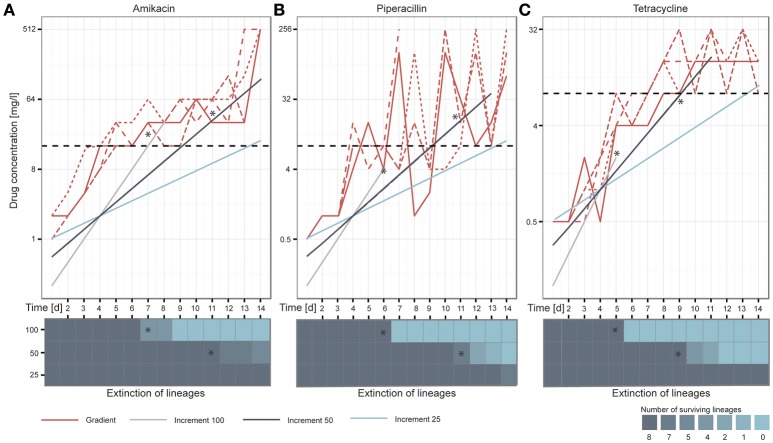
Overview of the adaptation potential over time for each drug: (A) amikacin, (B) piperacillin, and (C) tetracycline. The lineages adapted under the gradient method follow the maximal selection pressure wherefore it can be observed that lineages from the increment approaches (100, 50, and 25) die out when they exceed the natural selection maximum defined by the gradient approach, indicated with stars in the figure. Replicates are represented in different line styles. The clinical breakpoint is indicated with a dotted line in black. The heatmaps illustrate the extinction of lineages over time.